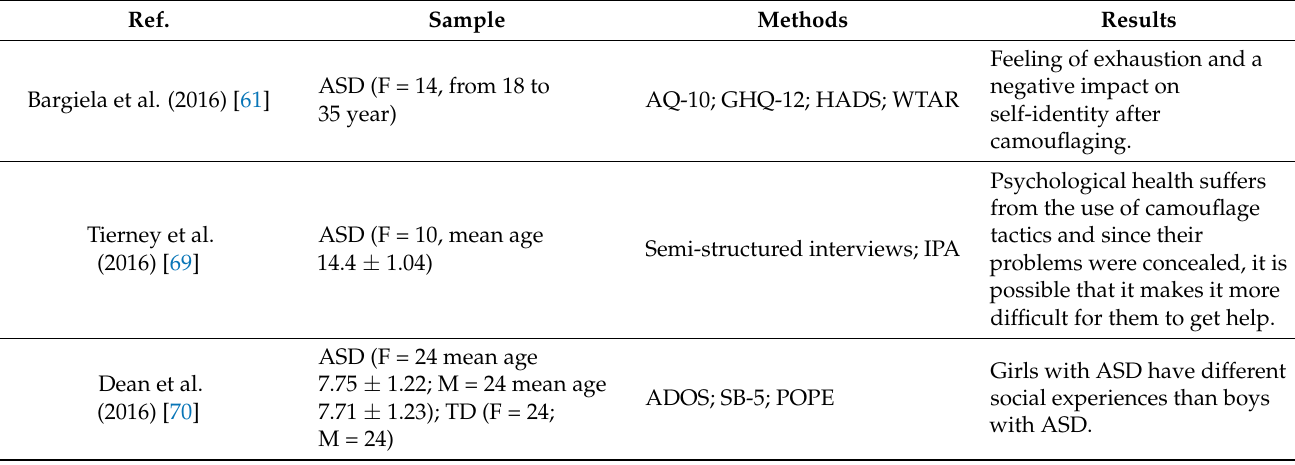
Table 1. The available literature on Social Camouflaging (Part